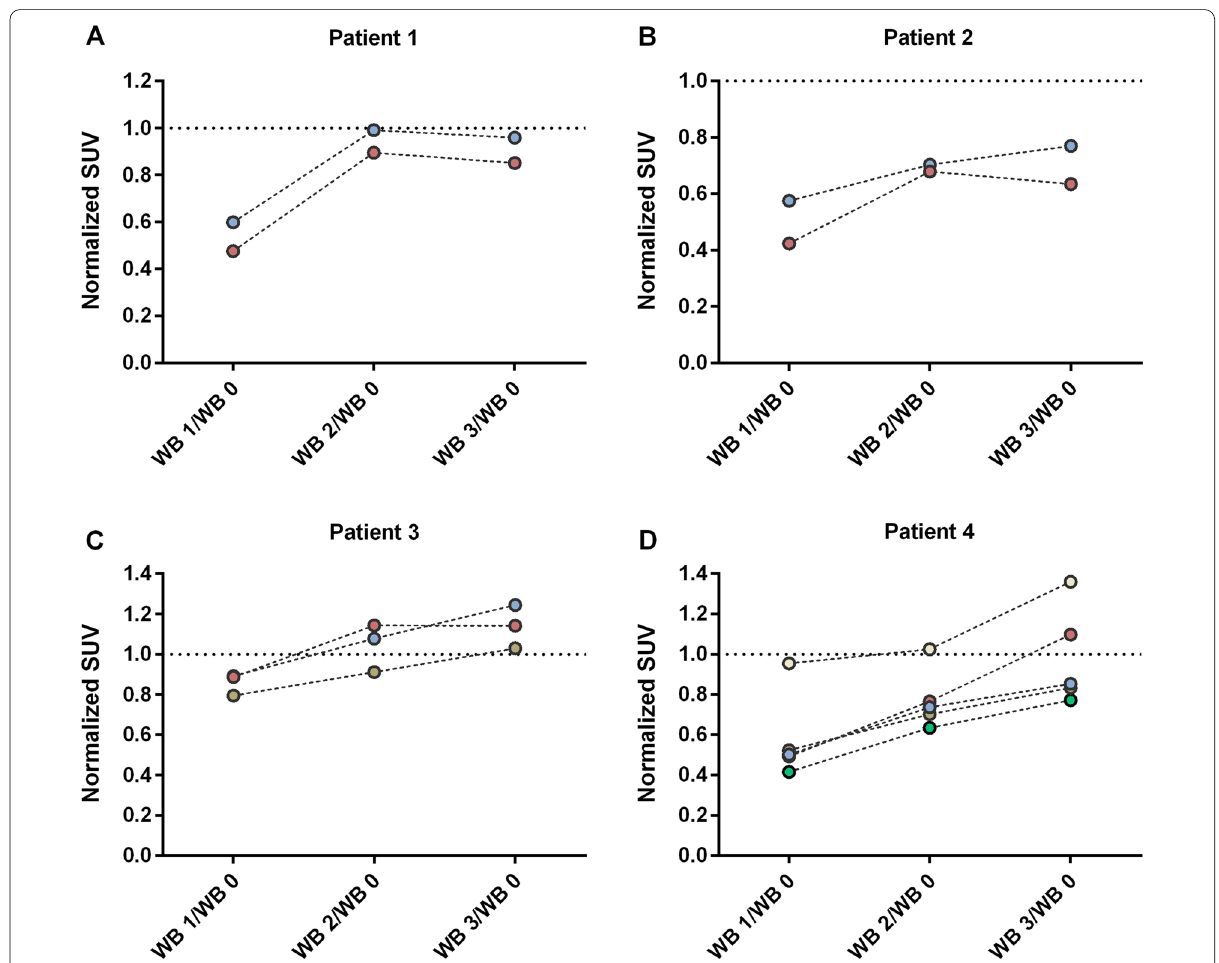
Fig. 2 Normalized tumor SUV, where SUV at WB 1 (0 h), WB 2 (4 h) and WB 3 (7 h) are normalized against WB 0 (SUV ratio) for patient 1 ( A ), patient 2 ( B ), patient 3 ( C ) and patient 4 ( D ). Each color represents one tumor and the dotted line represents a normalized SUV of